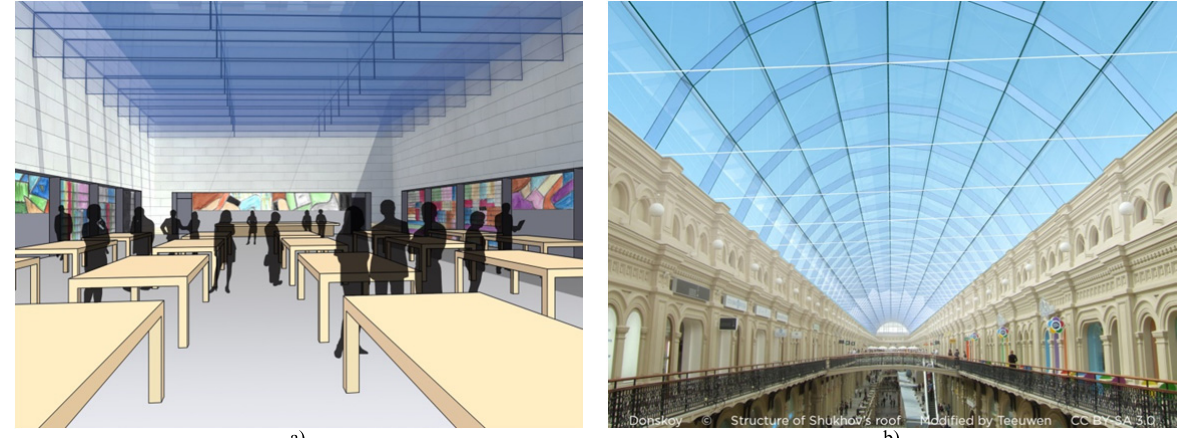
Fig. 12 Impressions of a segmented beam and arch, using edge-integrated